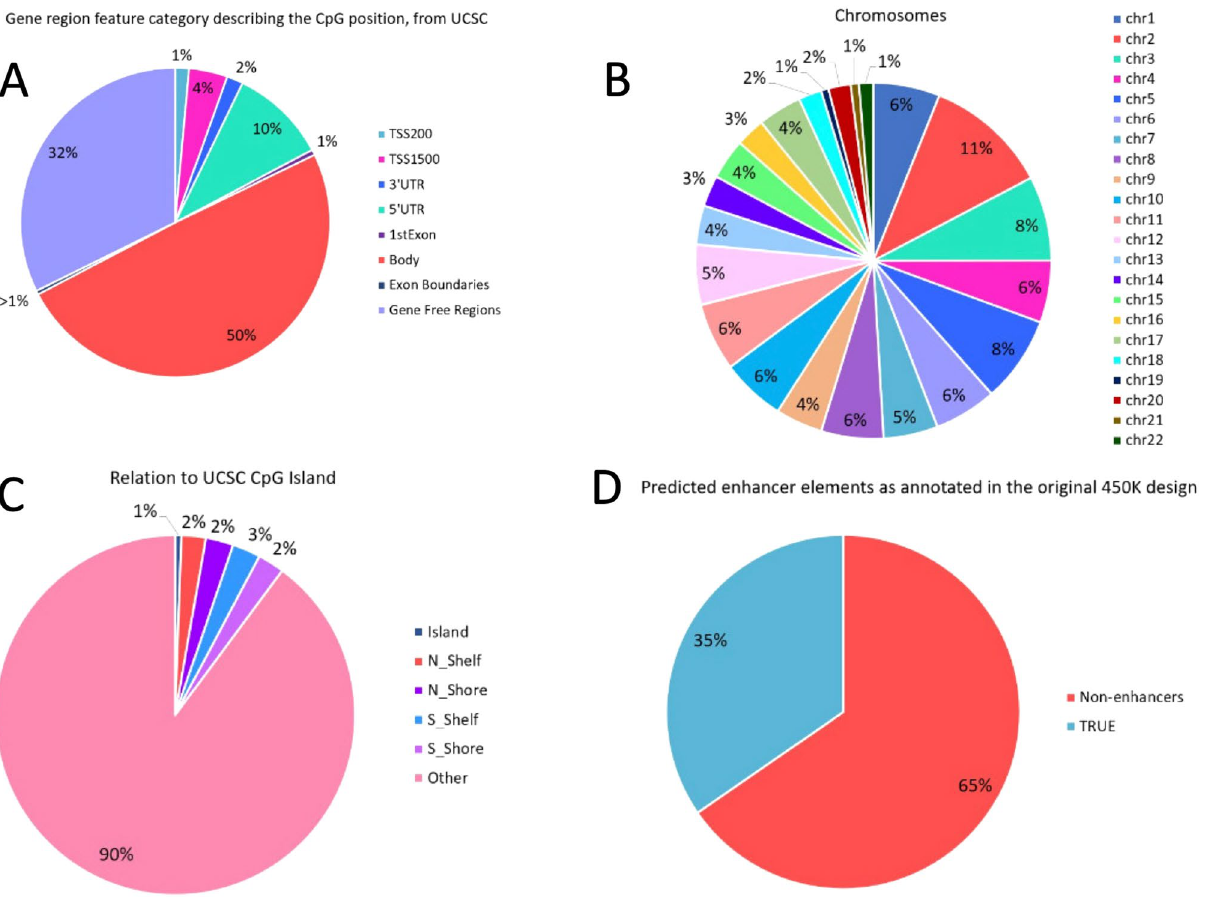
Figure 4. Genomic localization analyses of CpG sites differentially methylated in cells recovered after BTZ treatment and controls. ( A )—according to the gene functional elements, ( B )—at chromosomes, ( C )—regarding CpG islands, ( D )—enhancer occupation sites.